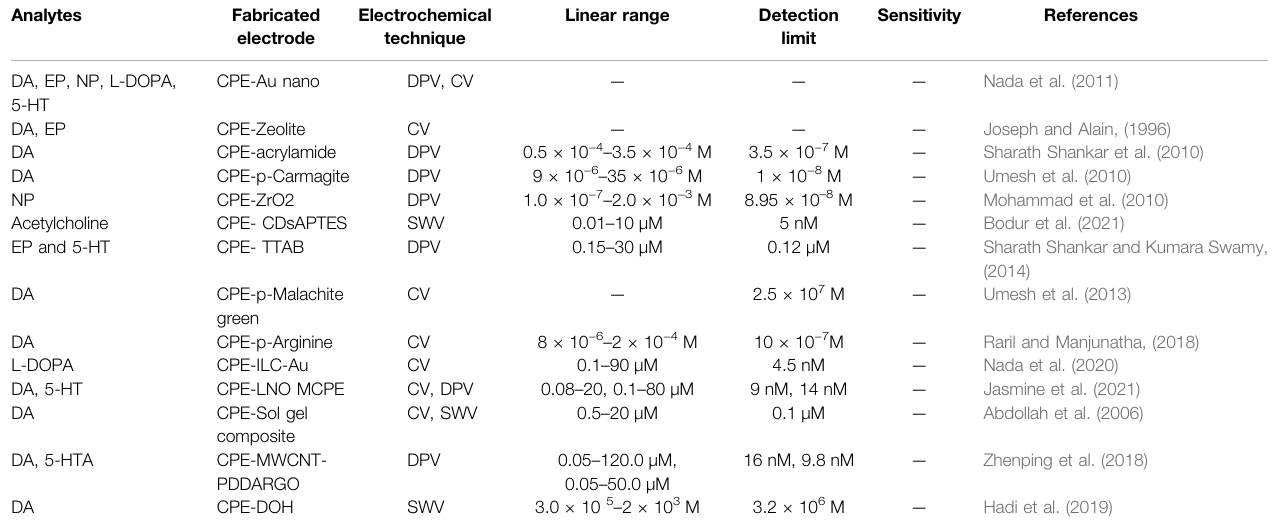
TABLE 2 | CPE modi fi ed sensors for neurotransmitters.